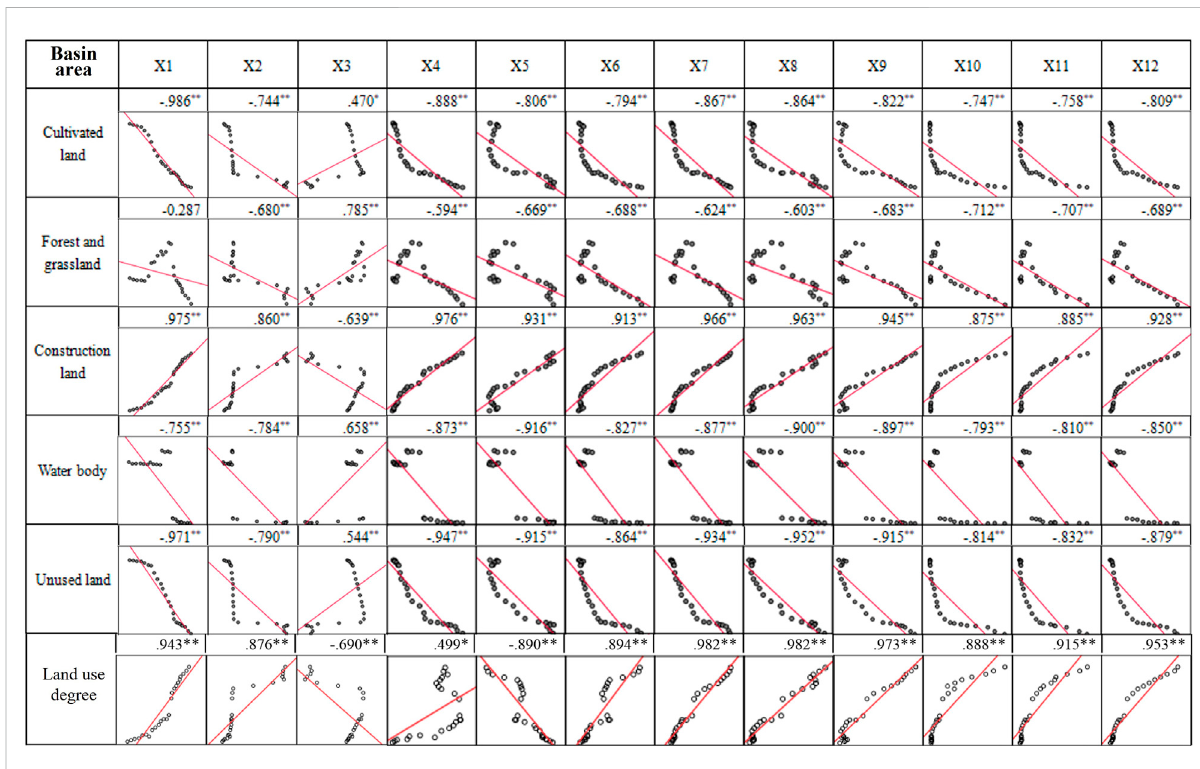
FIGURE 8 Correlation between land use types, land use degree and in fl uencing factors in the basin